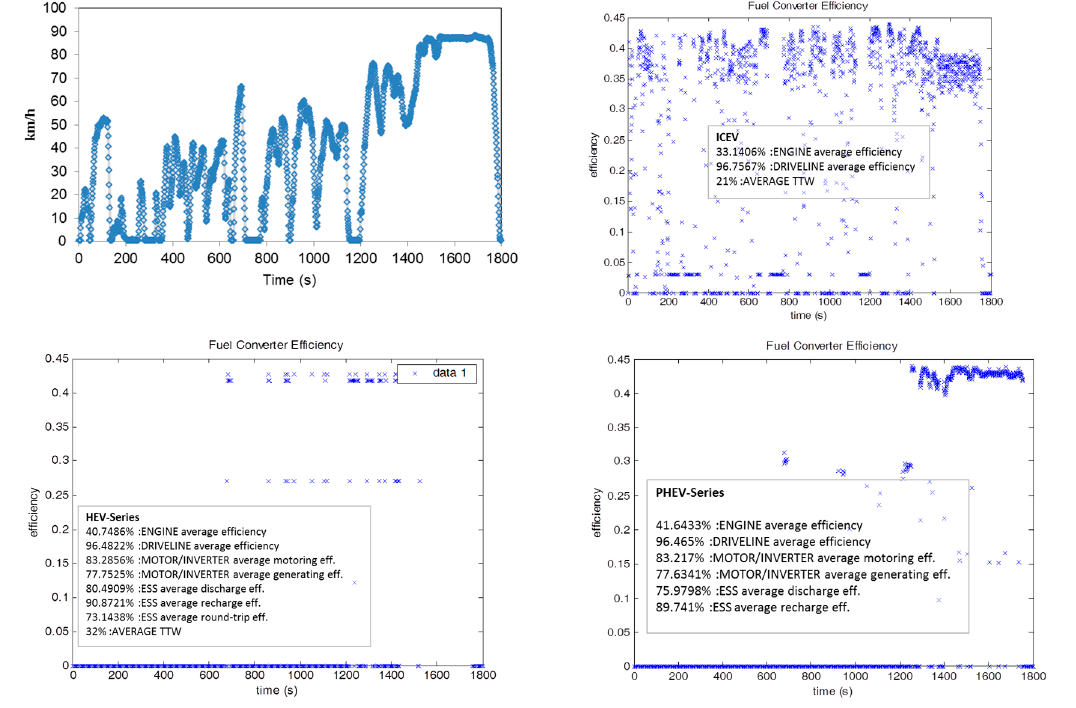
Figure 5. ADVISOR model efficiencies for a specific driving cycle and PHEV energy management (average speed 40 km/h, distance 20 km, 12 stop-&-go situations). “Cross check” of efficiency assumptions. Table 8. Final energy consumption by source and per year, with uncertainty.